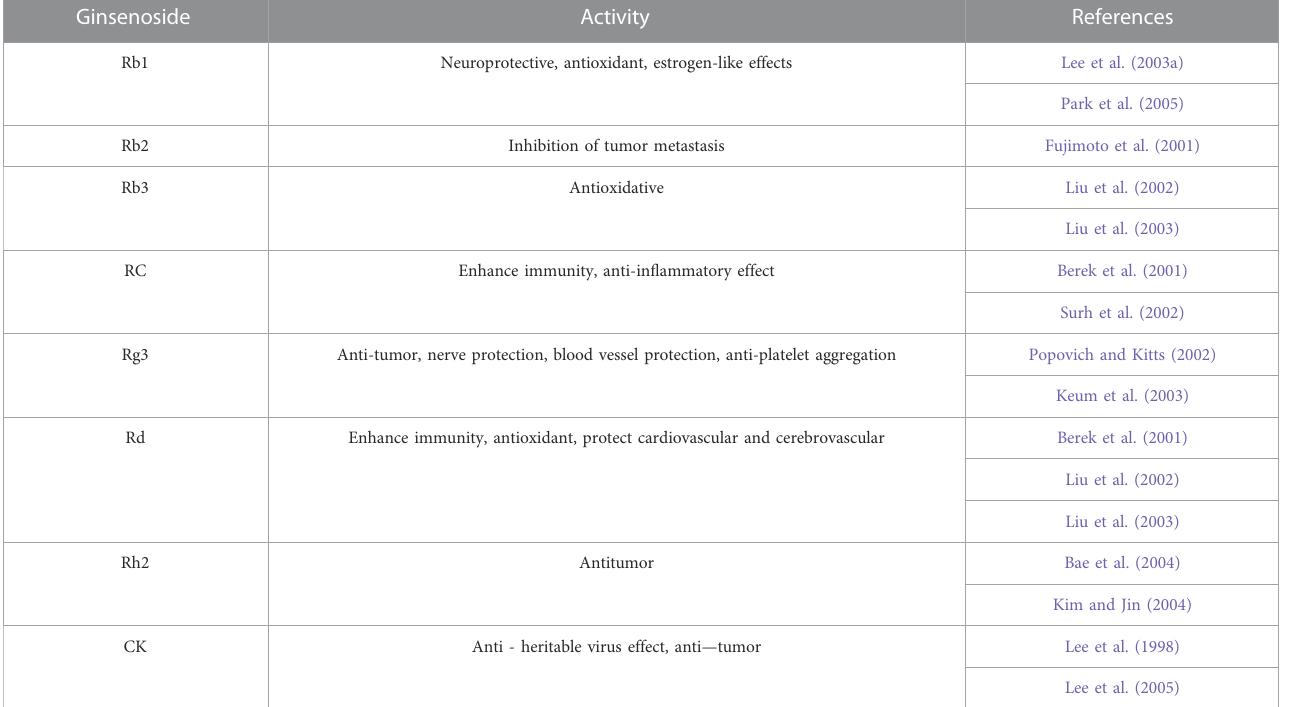
TABLE 2 Pharmacological activity of PPD type ginsenosides. Ginsenoside